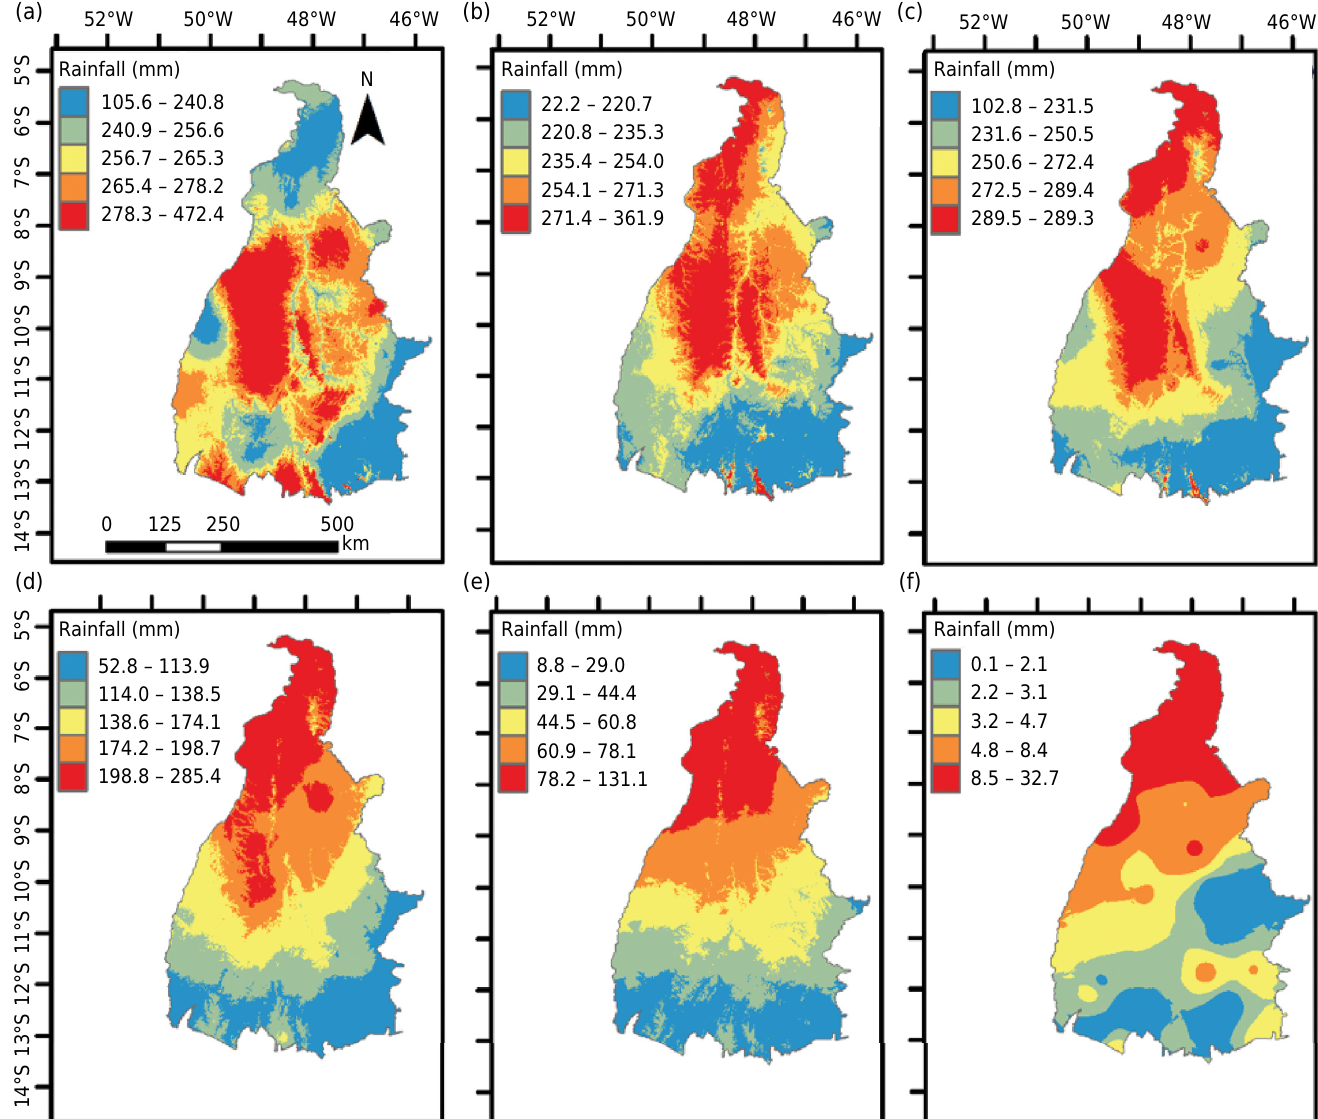
Figure 4. Maps generated by regression-kriging for rainfall estimated data for the months of January (a), February (b), March (c), April (d), May (e), and June